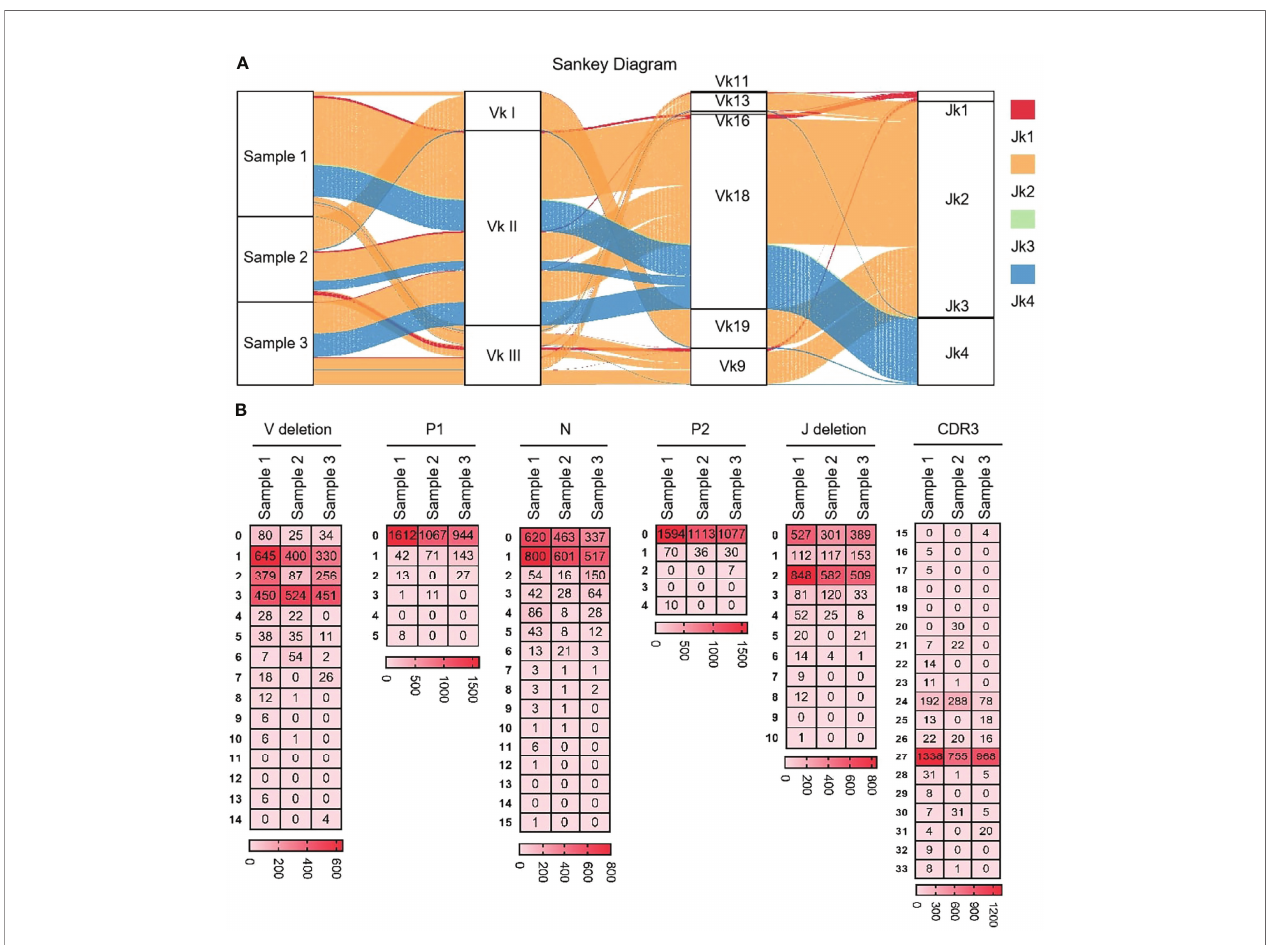
FIGURE 7 | The diversity of VJ recombination and CDR3 length in yak IgL( k ). (A) The sankey diagram of VJ recombination in yak IgL( k ); (B) the nucleotides distribution of V deletion, P1 nucleotide, N nucleotide, P2 nucleotide, J deletion and CDR3 in yak IgL( k